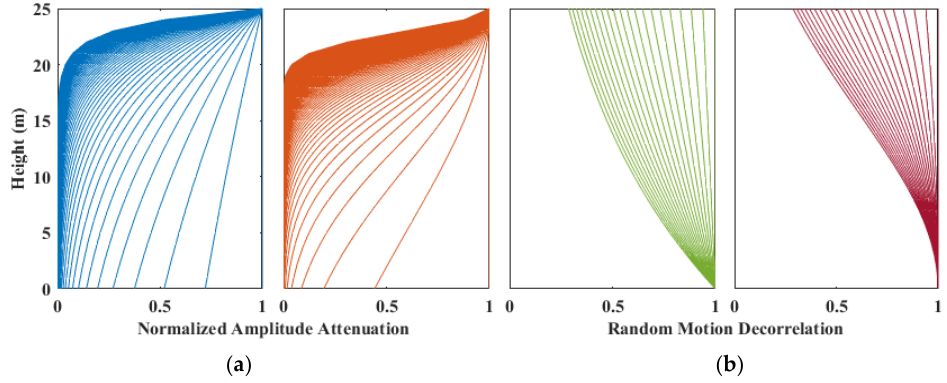
Figure 4. Shape evolutions of the volumetric scattering attenuation and random motion. ( a ) LVA ( left ) and QVA ( right ); ( b ) LVM ( left ) and QVM ( right